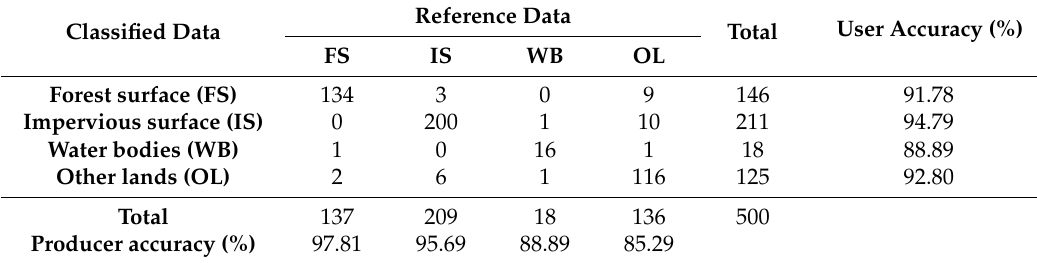
Table A1. Error matrix for the 1996 LULC classification.